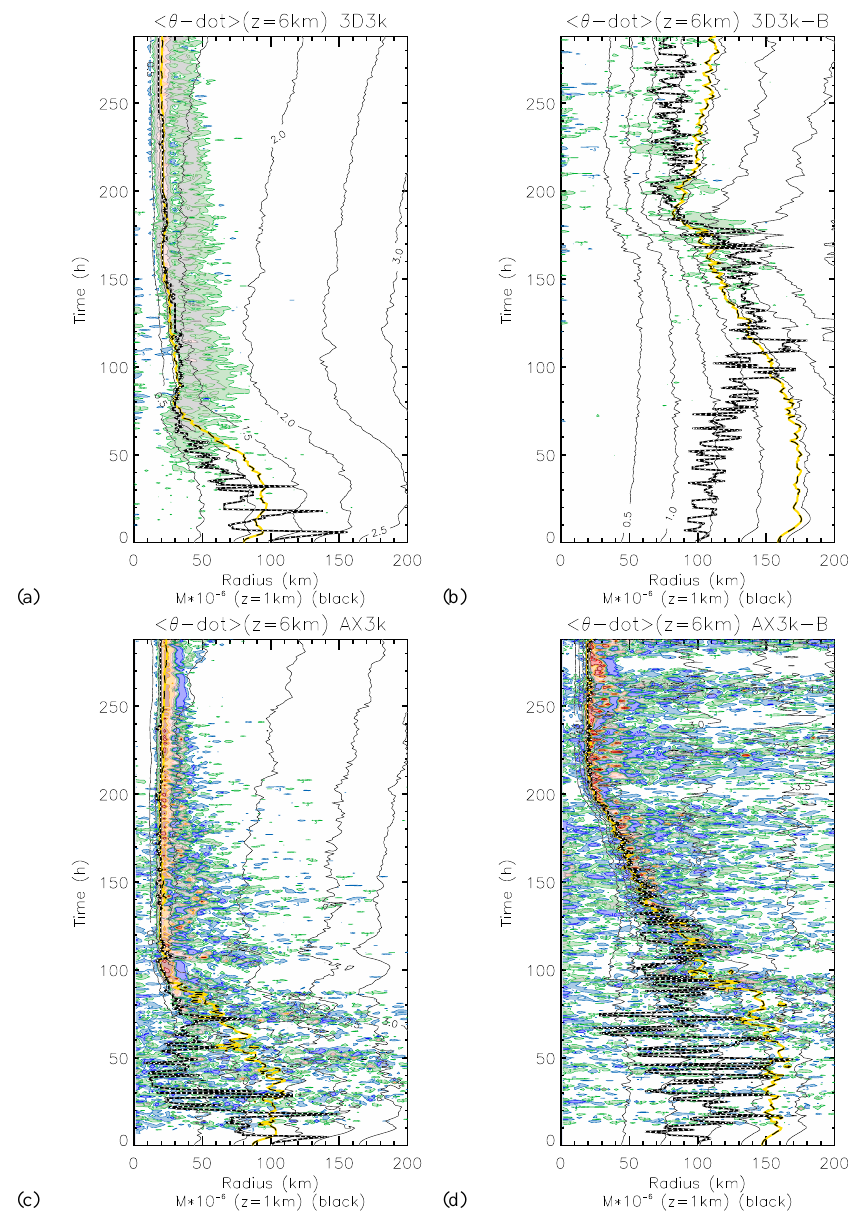
Fig. 23. Axisymmetric mean heating rate ( h ˙ θ i , shaded) and axisymmetric mean absolute angular momentum ( h M i , black contours, interval 0 . 5 × 10 6 m 2 s − 1 ) from the (a) 3D3k, (b) 3D3k-B, (c) AX3k, and (d) AX3k-B simulations. Colored h ˙ θ i contours (K h − 1 ) are -10 (dark blue), -3 (blue), 3 (green), 10 (light green), 30 (gray), 50 (pink), 75 (orange), 100 (red), 150 (red), and 200 (black). The white-spotted black line is the RMW. The yellow-dashed black line is the value of h M i found at the RMW at times of mature intensity for each simulation.